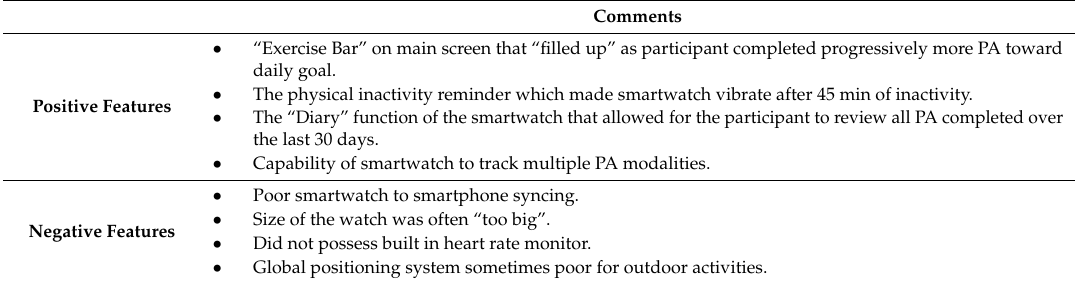
Table 1. Experimental Participants’ Comments Regarding Polar M400 Features.